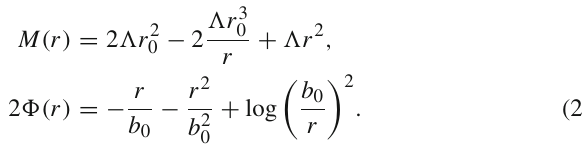
Fig. 2 Difference between the route times of the charge carrier by equivalent distances, in picoseconds, on a graphene sheet. The first time interval corresponds to a route traveled on a usual flat sheet and the second one to the radial path run through a Casimir wormhole that joins two of its regions, as a function of q , in meters, for the throat radii indicated in the legend and (cid:10) = 2 . 46